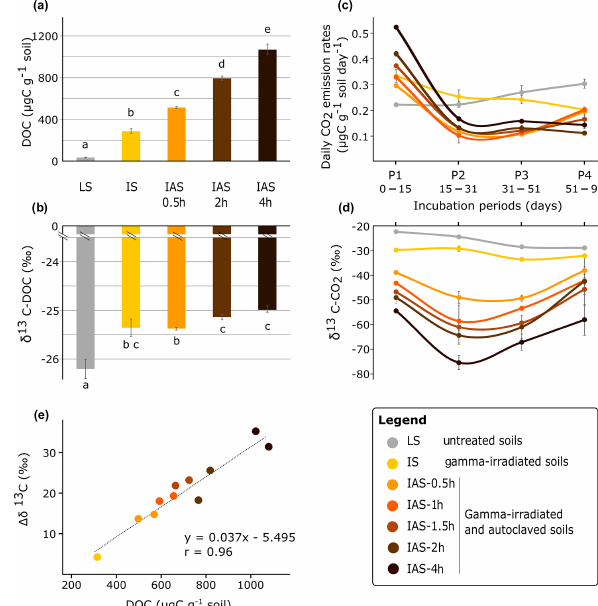
Figure 3. Content and isotopic composition of both dissolved or- ganic carbon (DOC) and CO 2 across time and treatments. (a) Con- tent of DOC and (b) δ 13 C-DOC at the beginning of incubation, (c) daily C-CO 2 emission rates and (d) δ 13 C of CO 2 released during four periods of incubation, and (e) correlation between the carbon isotope discrimination ( (cid:49)δ 13 C in ‰) induced by the extracellular oxidative metabolism (EXOMET) and the DOC content. The cor- relation was calculated from sterilized soil treatment data (IS and IAS-0.5h, IAS-1h, IAS-1.5h, IAS-2h, and IAS-4h) analyzed at the beginning and end of incubation. Standard deviation was estimated using three replicates per condition ( n =